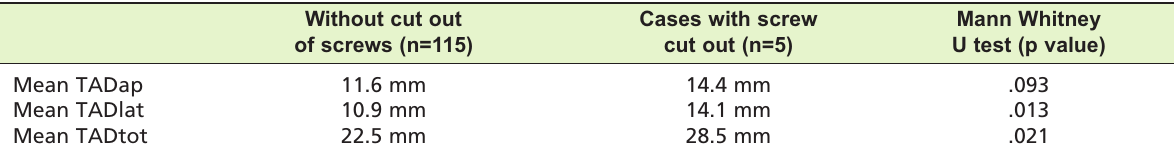
Comparison of TAD in screw cut out group vs non cut out Table VI: